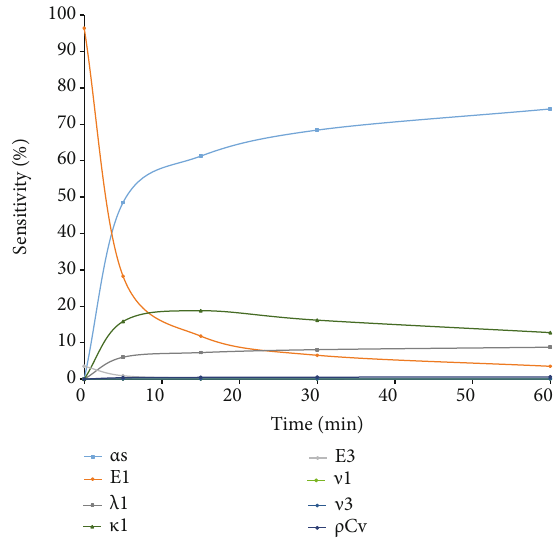
Figure 10: Sensitivity ranking for the fracture width (mm) for time interval t = ½ 0, 60 (cid:2) (min).